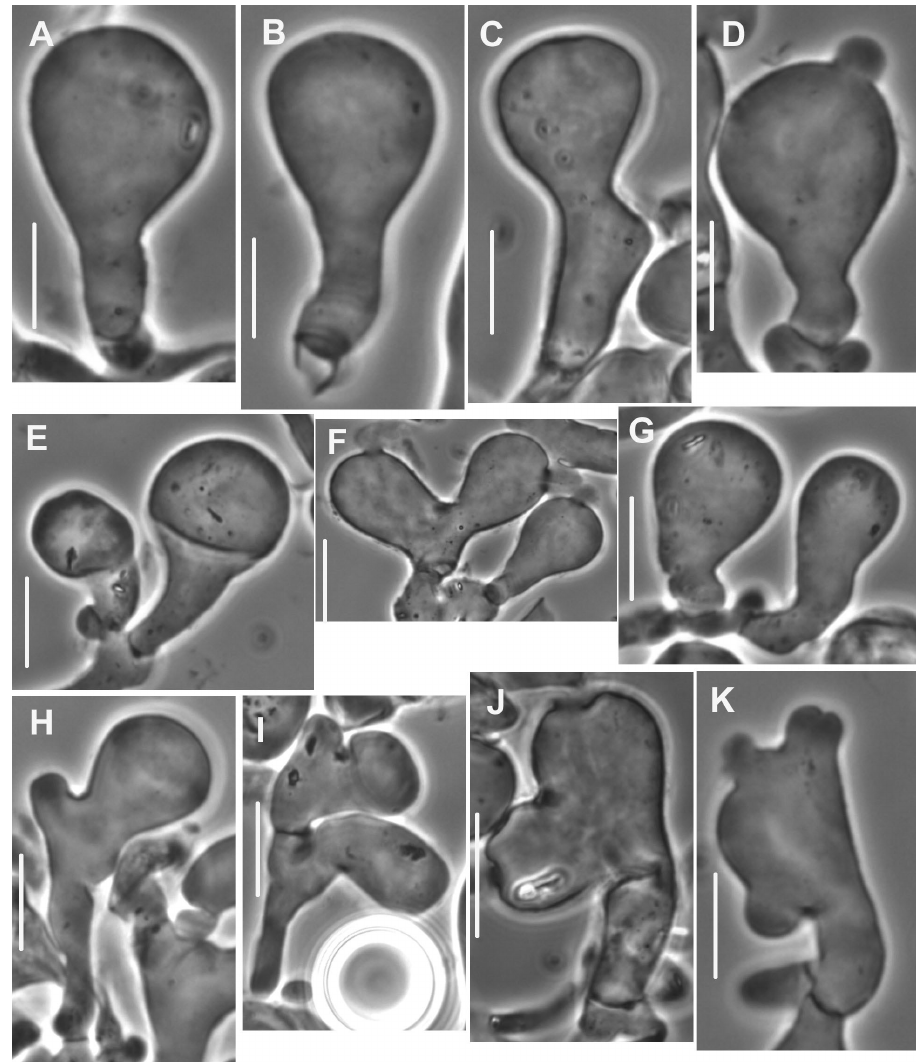
Figure 60. Mycetinis prasiosmus . Pileipellis structures. Standard bars = 10 µm. UPS-F-740438. narrowly to broadly fusiform, stalked, conspicuously clamped. Subhymenial hyphae branched, thin-walled, 2.5–4.0 µm diam. Pileus and hymenophoral trama subregular to irregular; hyphae cylindrical or slightly inflated, hyaline, thin-walled, 2.0–14(20) µm diam. Basidioles 19–38 × (3.0)4.5–10 µm, cylindrical to subampulliform; basidia (Figs 61E–H, 62) ( 26-)30–38 × (5.0-)6.0–10 µm, cylindrical or clavate, hardly sub- capitulate, (2-)4-sterigmate, conspicuously clamped; contents heterogeneous, appearing oily. Basidiospores (Fig. 63B) (7-)9–10.5(-12.5) × (3.5-)4–5.5(-6) µm (Q = 1.63–2.25; Q m = 1.97; L m = 9.2 µm), ellipsoid to elongate pip-shaped, tapered slightly